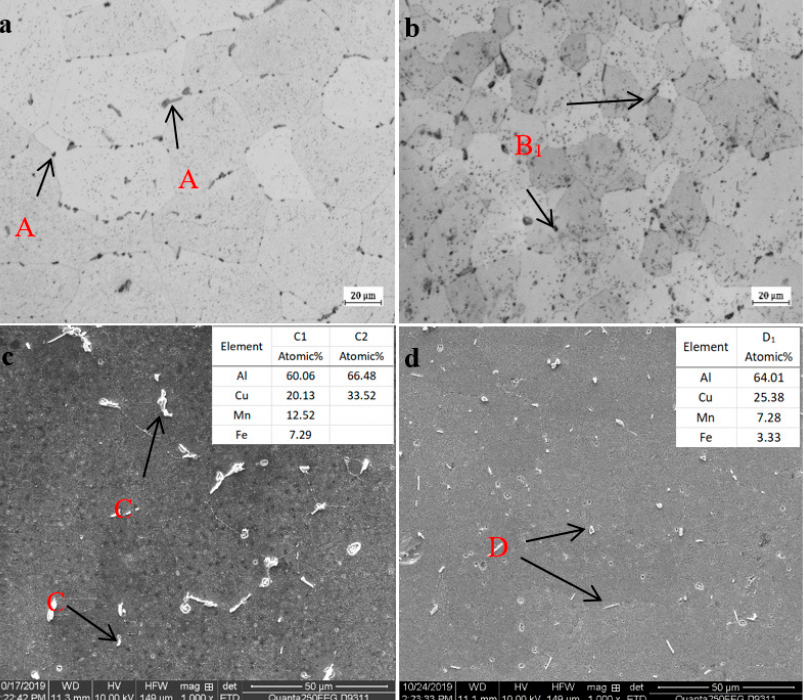
Figure 5. Metallographs of ( a ) single-wire wall and ( b ) double-wire wall; SEM and EDS of ( c ) the single-wire wall and ( d ) double-wire wall in T6 state.